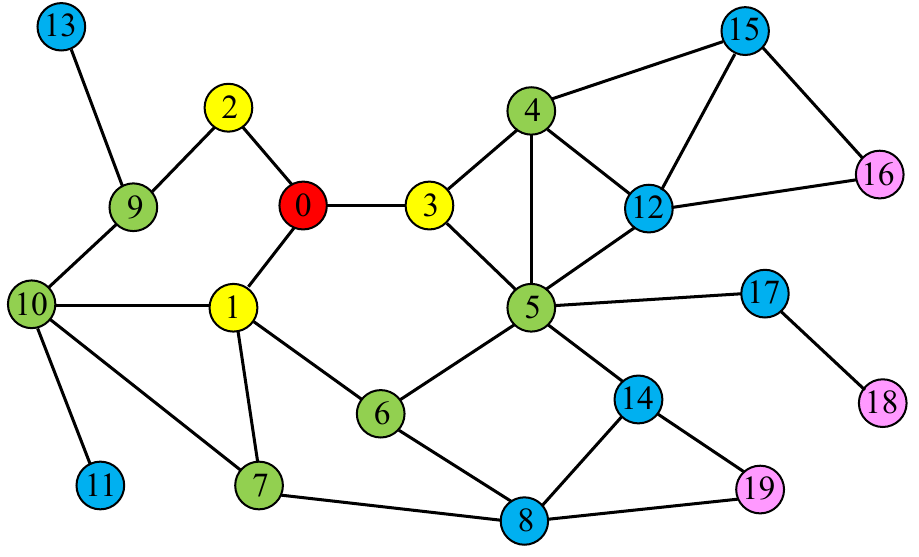
Figure 1. The topology of the example network.